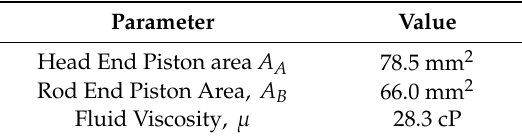
Table 2. Best fit cylinder friction parameters.